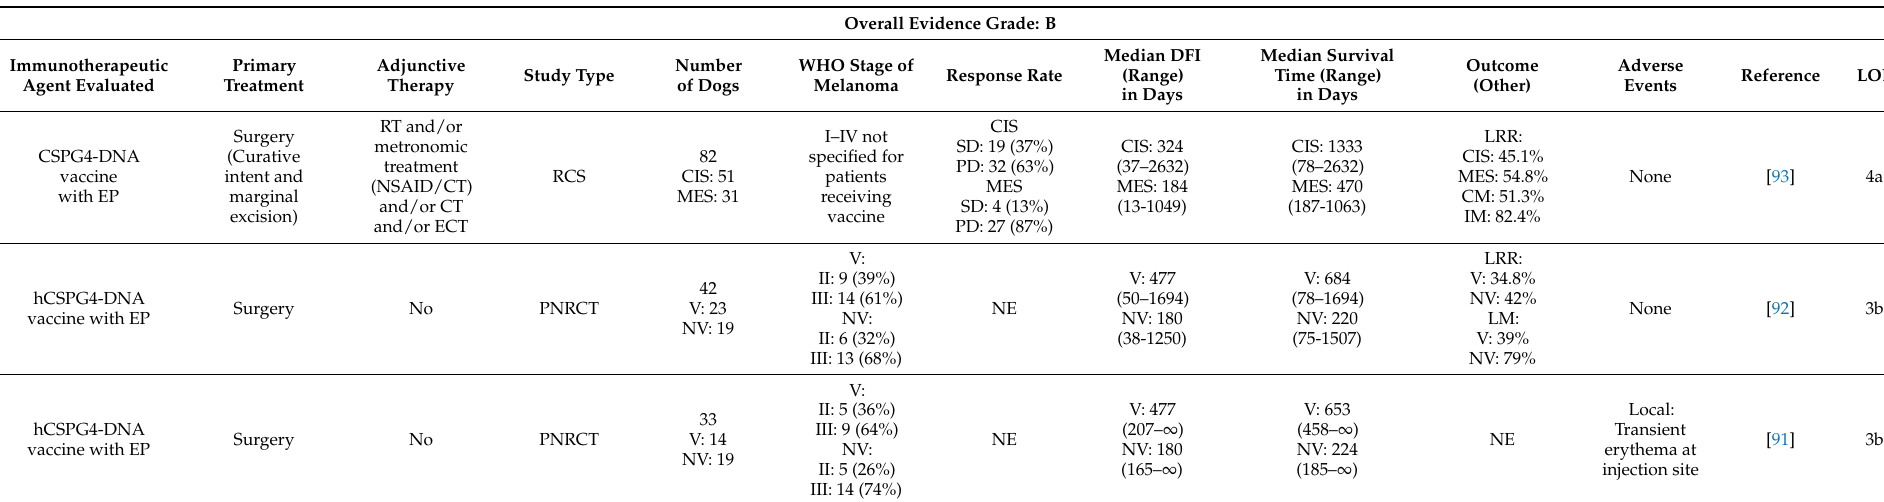
Table 11. Summary of electrovaccination studies evaluating effectivity in oral malignant melanoma. Overall Evidence Grade: